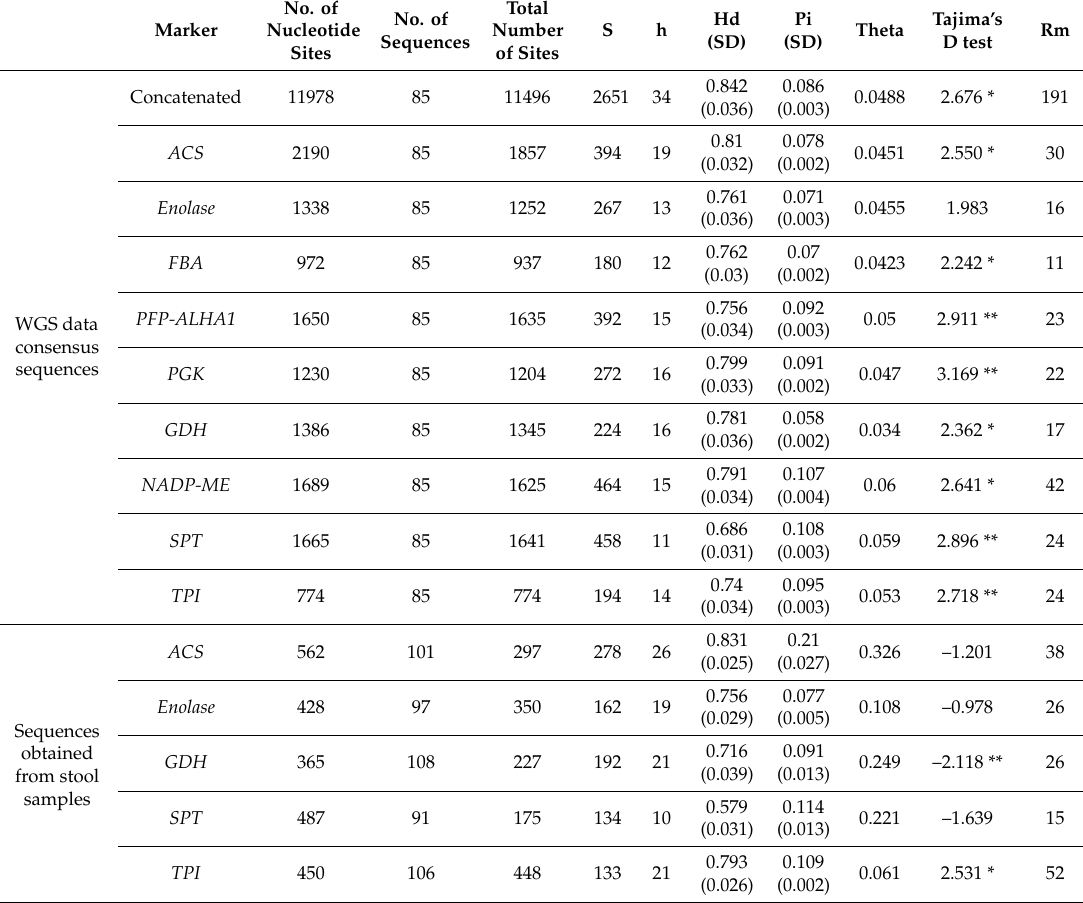
Table 1. Diversity indices obtained for the evaluated